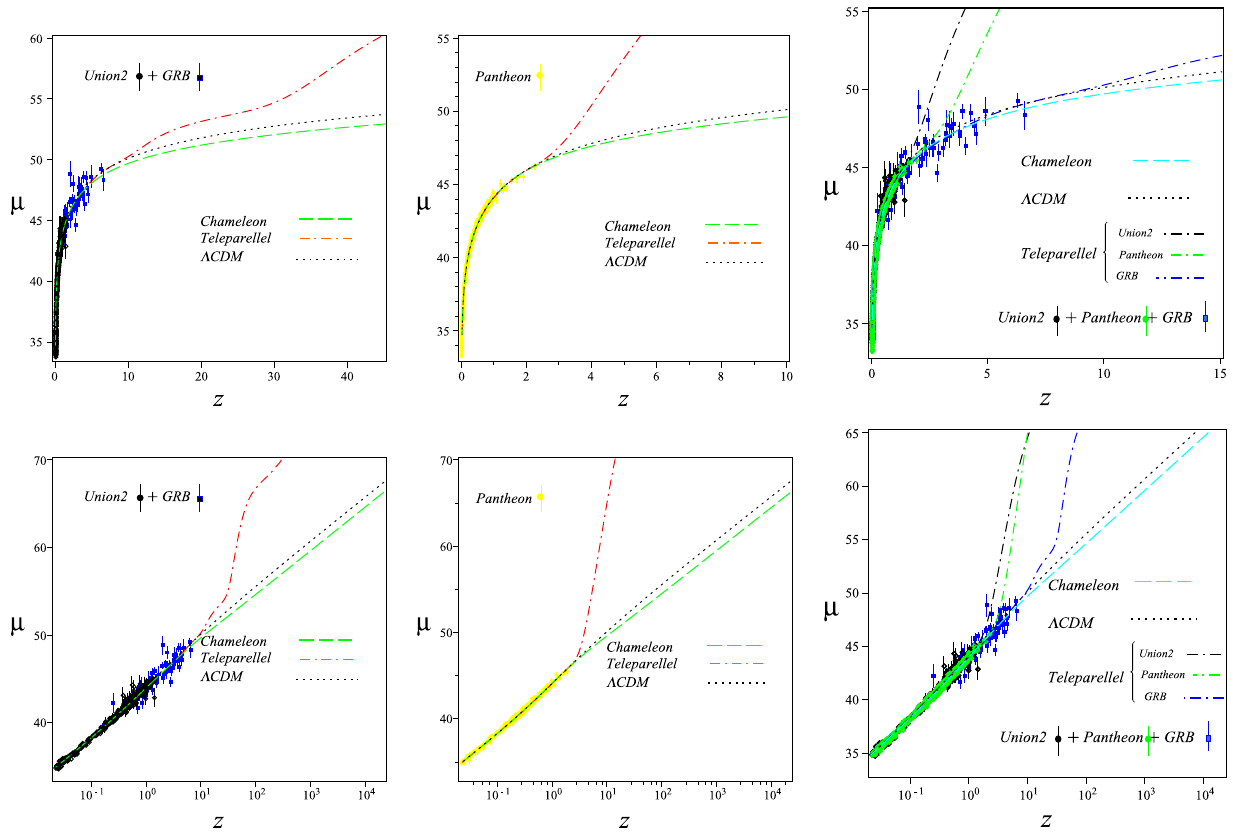
Fig. 1 The distance modulus μ( z ) vs. redshift best fitted with Union2, Pantheon and GRB data in Teleparallel, Chameleon and (cid:2) CDM